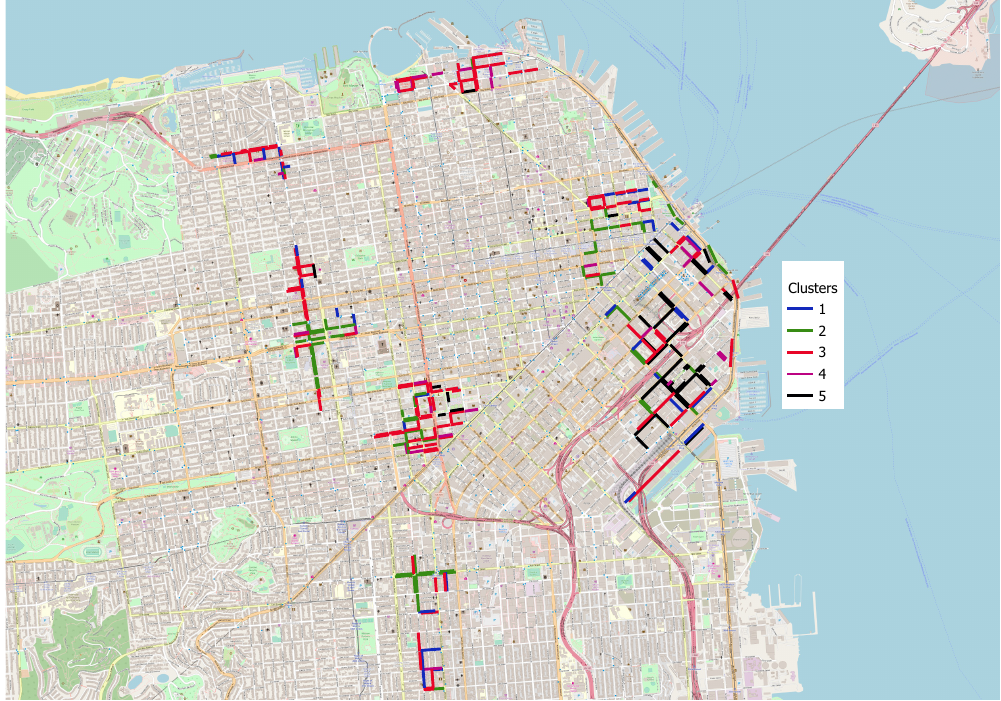
Figure 10. Geographic distribution of clusters among the considered road segments in the SFPark